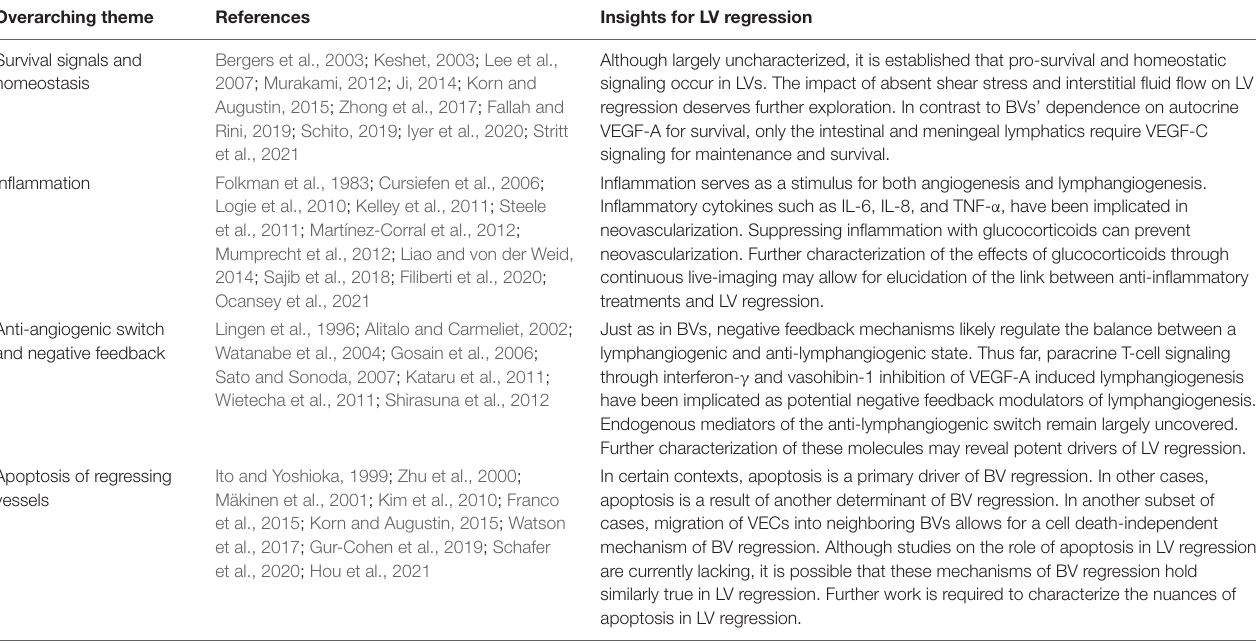
TABLE 2 | Extending BV regression hallmarks to lymphatic vessels (LV)